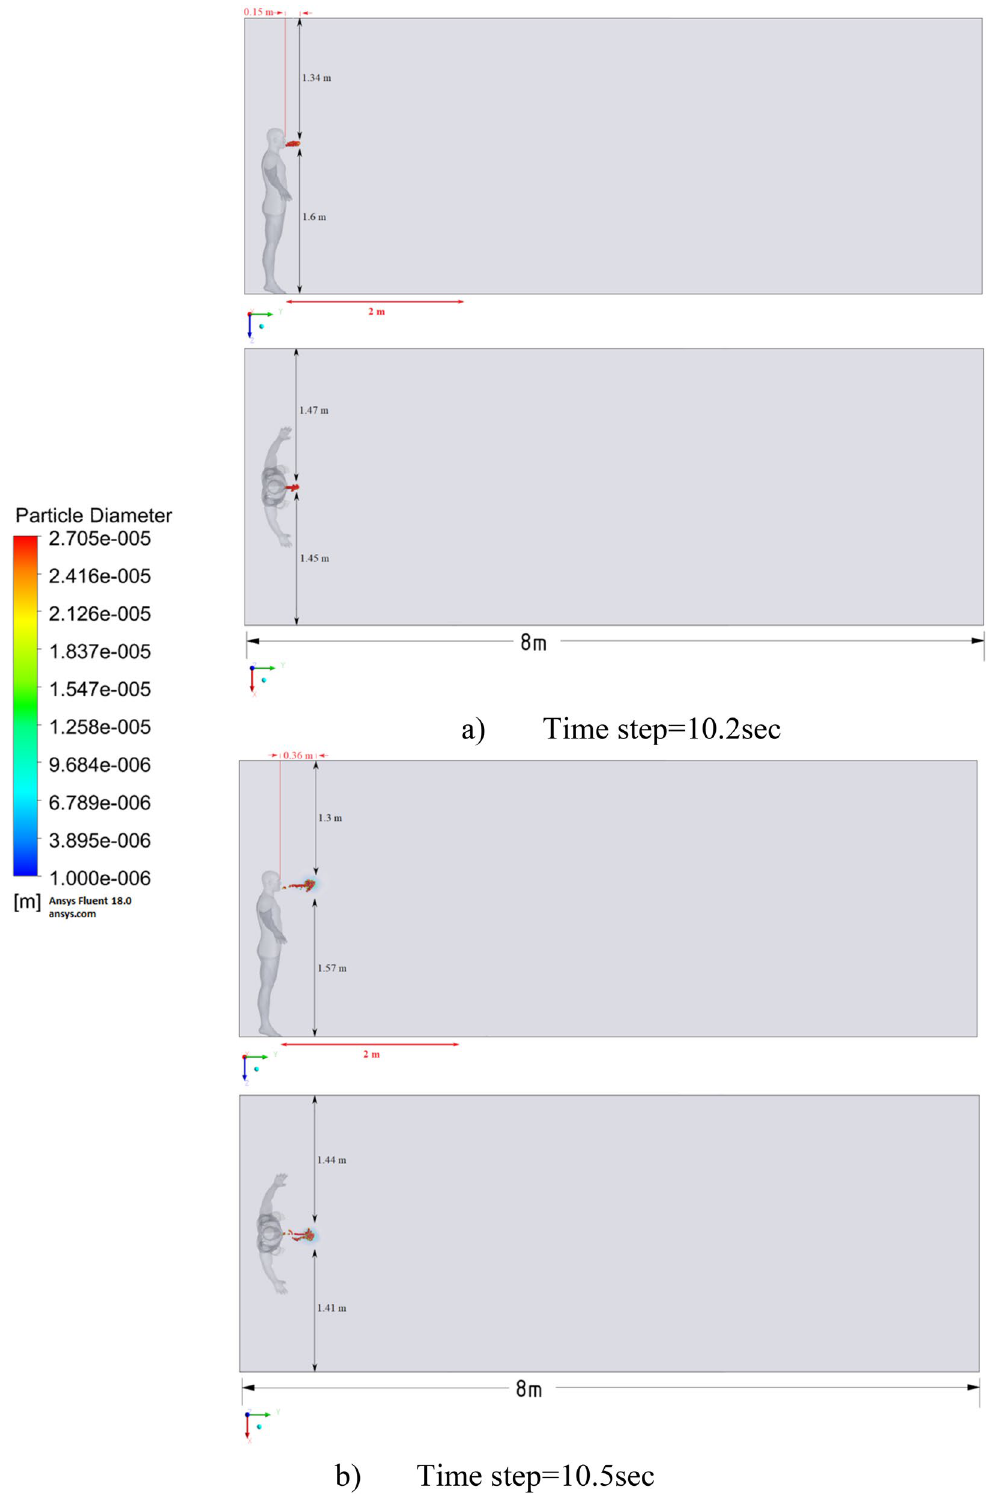
Figure 22. Distribution of the particles for cough = 6 m/s and ventilation = 1